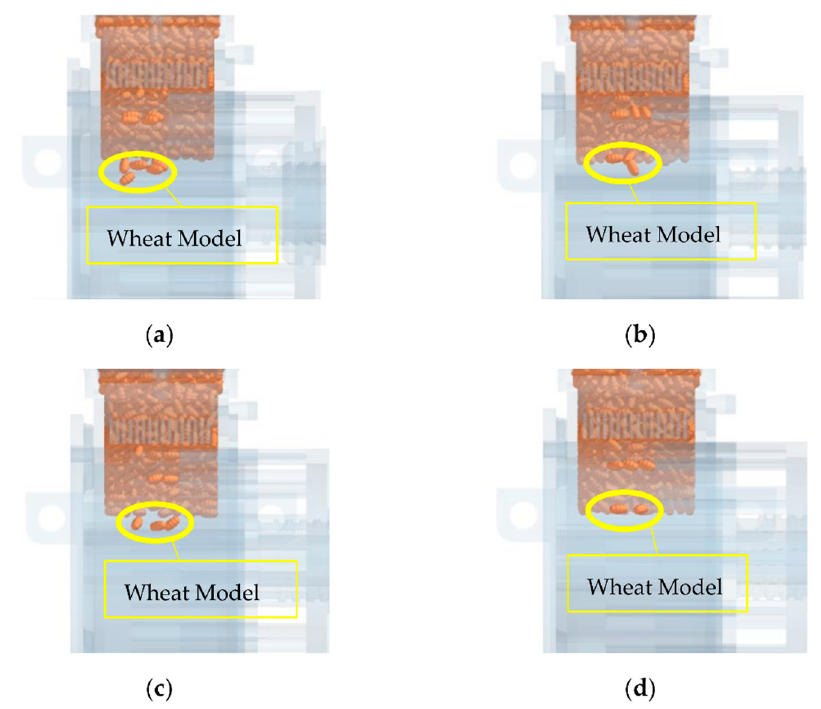
Figure 11. The number of grains of wheat seed filled with various model-hole types. ( a ) Inverted-fin-shape model-hole; ( b ) Inclined parabolic model-hole; ( c ) Bowl-shaped model-hole; ( d ) Prism-shaped model-hole.